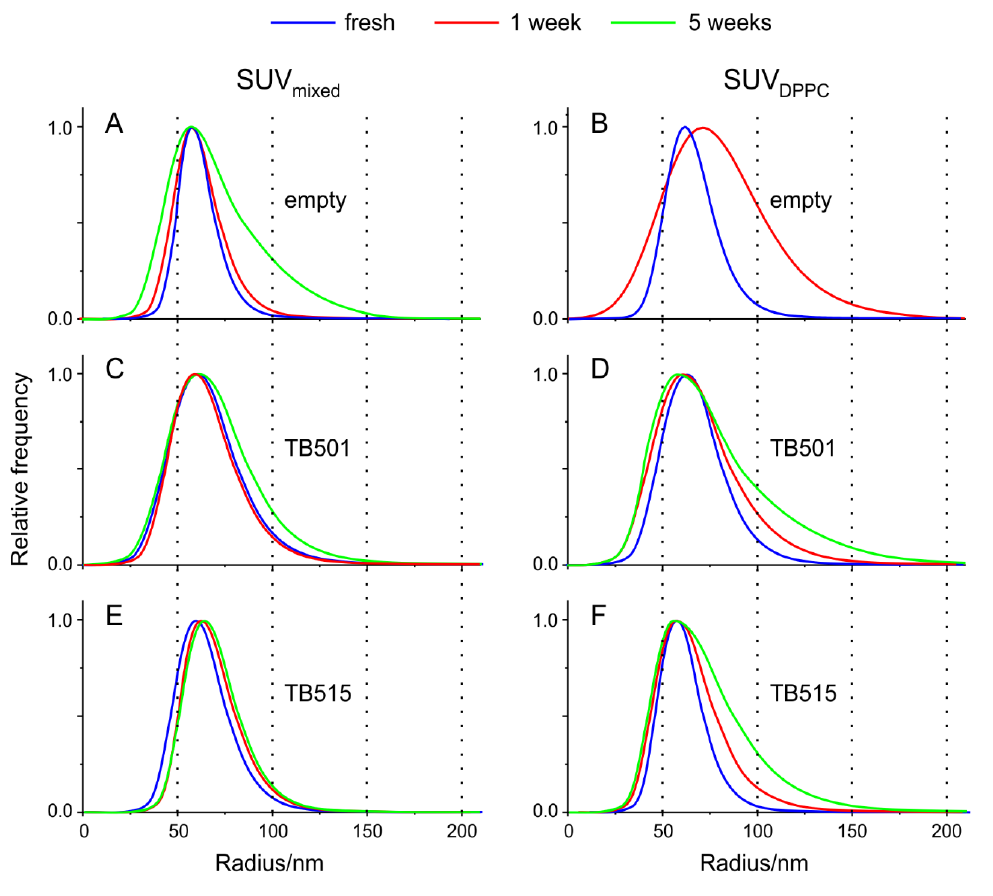
Figure 2. ( A – F ) Homogeneity and long-term stability of liposomes are measured by dynamic light scattering (DLS). The size distribution of the two types of small unilamellar vesicles (SUVs) (SUV mixed and SUV DPPC ) without and with the two antitubercular agent candidates separately (TB501 and TB515): blue curve freshly prepared; red after one week; green after five weeks (in the case of empty SUV DPPC after five weeks, the DLS autocorrelation function could not be evaluated).